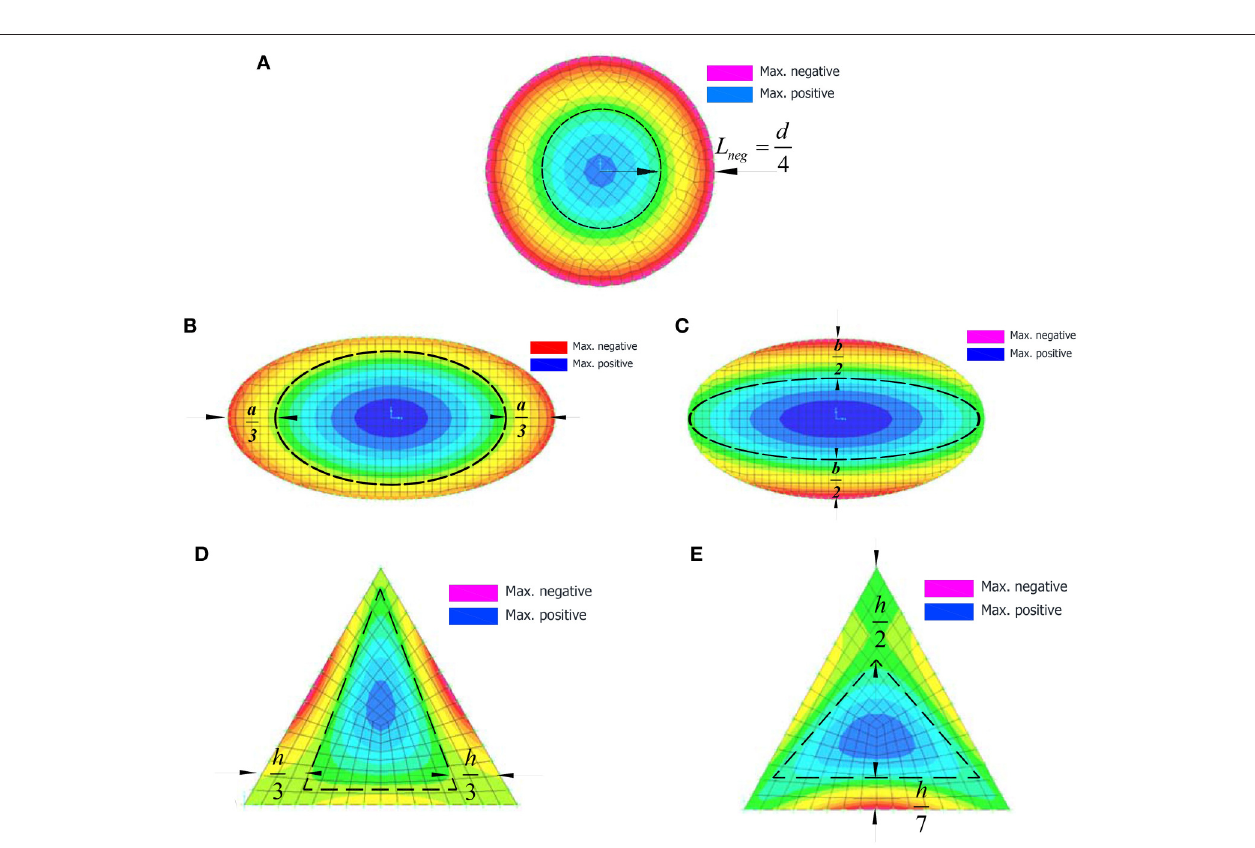
FIGURE 7 | Moment distribution in: (A) circular slab, (B) elliptic slab along horizontal strip (C) elliptic slab along vertical strip, (D) triangular slab along horizontal strip, and (E) triangular slab along vertical strip.